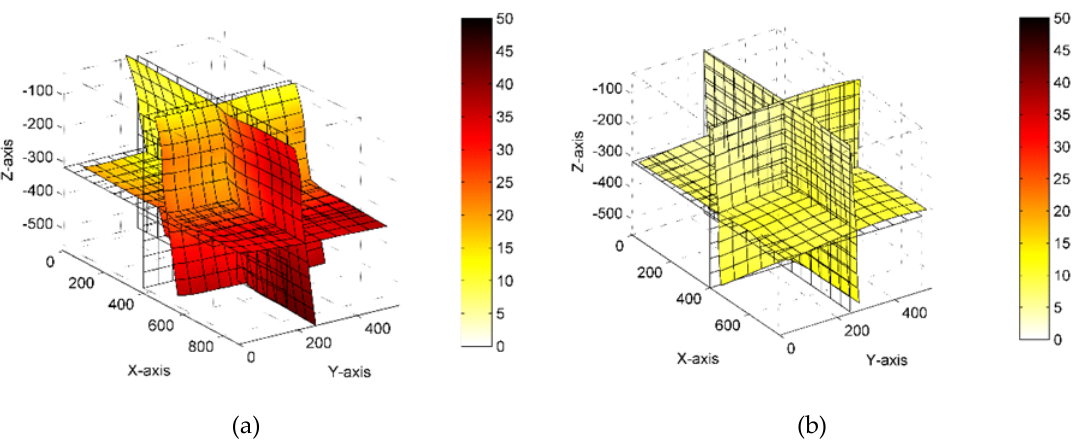
Figure 7. Graphical representation of the volumetric errors in the machine workspace: ( a ) without volumetric compensation of 49 µm—calibration; ( b ) with volumetric compensation of 14 µm—verification.